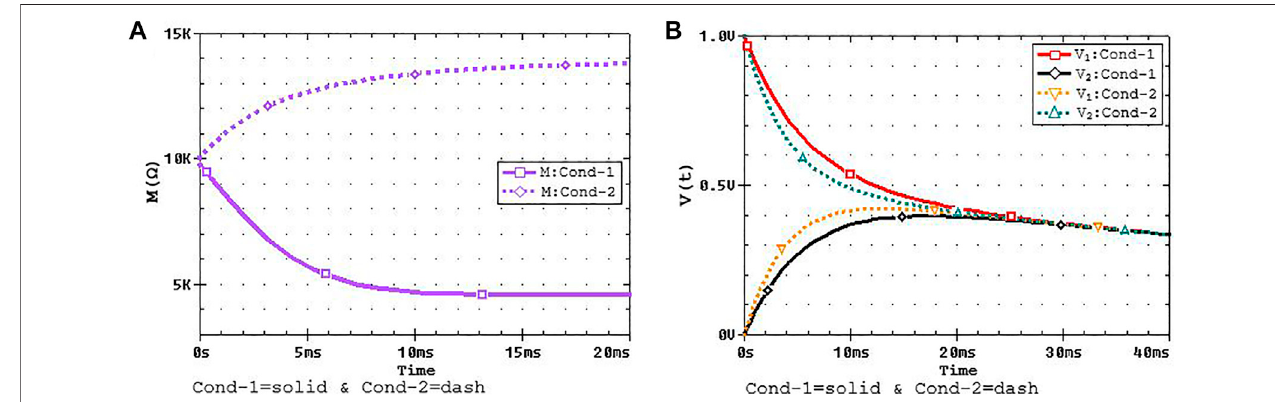
FIGURE 6 | The interaction of the cells according to Cond-1 (solid curves) and Cond-2 (dash curves) for q 0 (cid:1) 38 μ C , R on (cid:1) 100 Ω , and R off (cid:1) 16 K Ω with V 1 (cid:1) 0 V for Cond-1 and V V 2 0